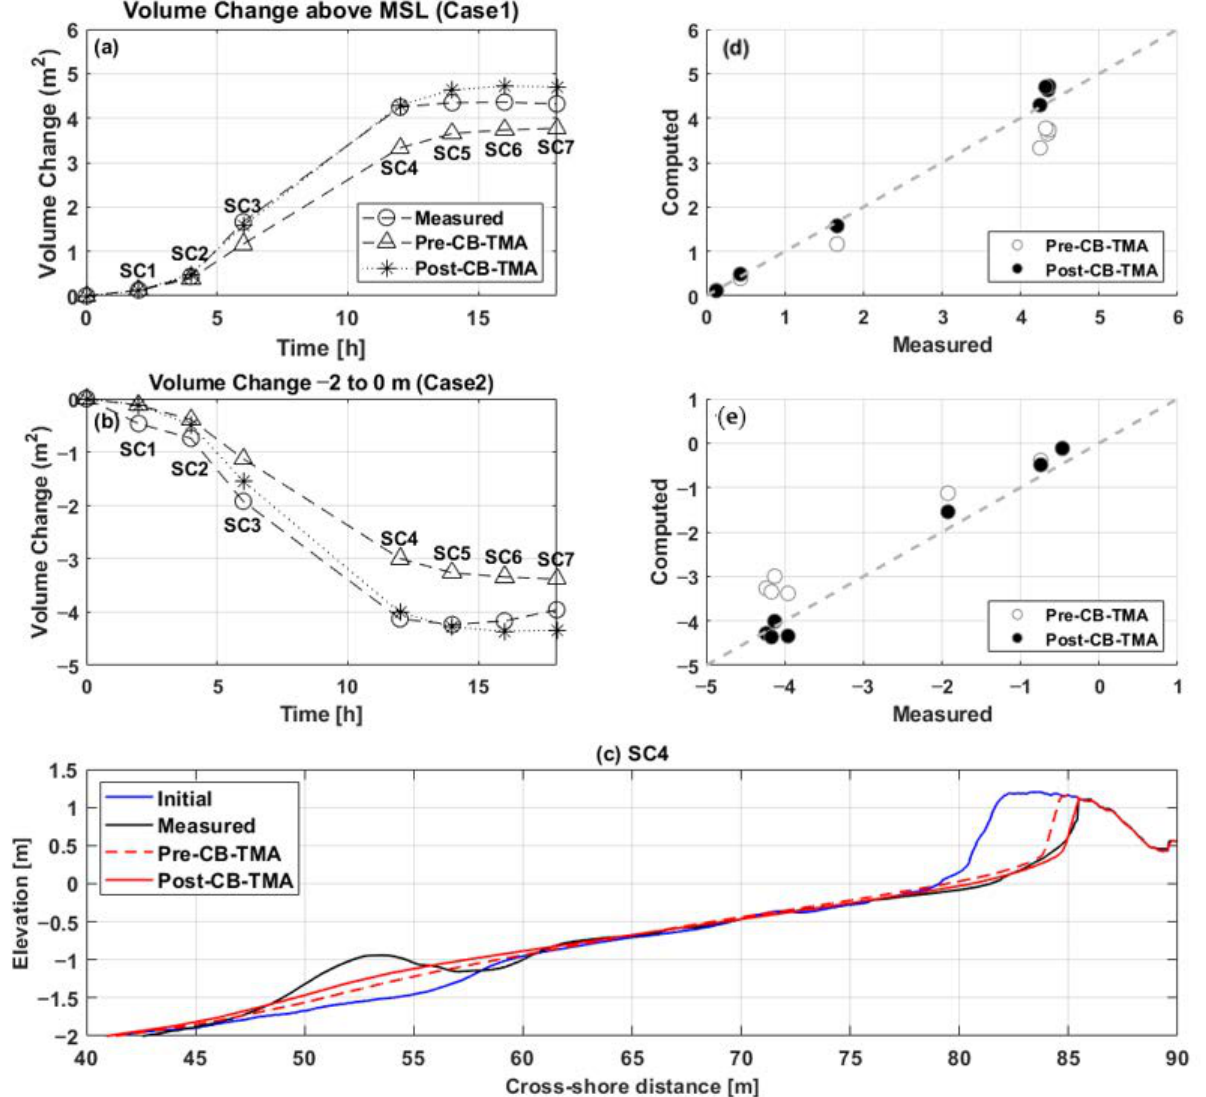
Figure 8. Measured and computed (pre and post-CB-TMA) volume changes of final profiles throughout the entire scenario ( a – d ) and profiles after SC4 ( e ): volume changes ( a ) above MSL and ( c ) between − 2 and 0 m and correlation ( b ) above MSL and ( d ) between − 2 and